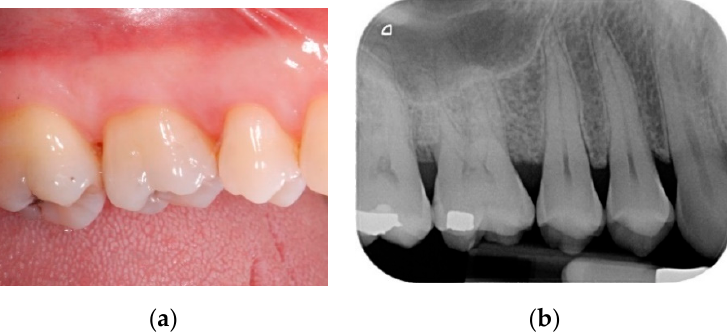
Figure 3. ( a ) Clinical view of the treated area at 12-month follow-up; ( b ) periapical radiograph at 12-month follow-up.